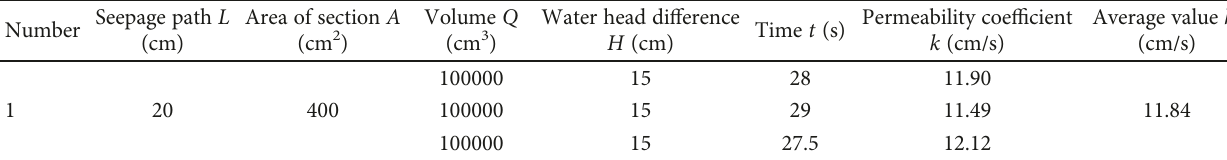
Table 4: Results of the penetration test for a fractured rock mass ( ξ = 0 7 ).